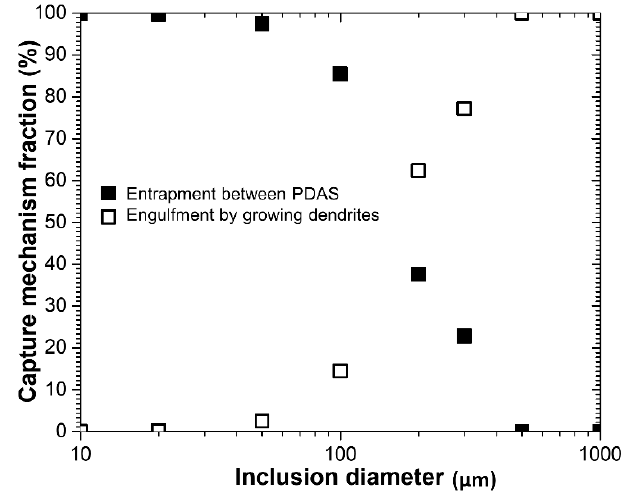
Figure 19. Inclusion capture mechanisms by inclusion size.